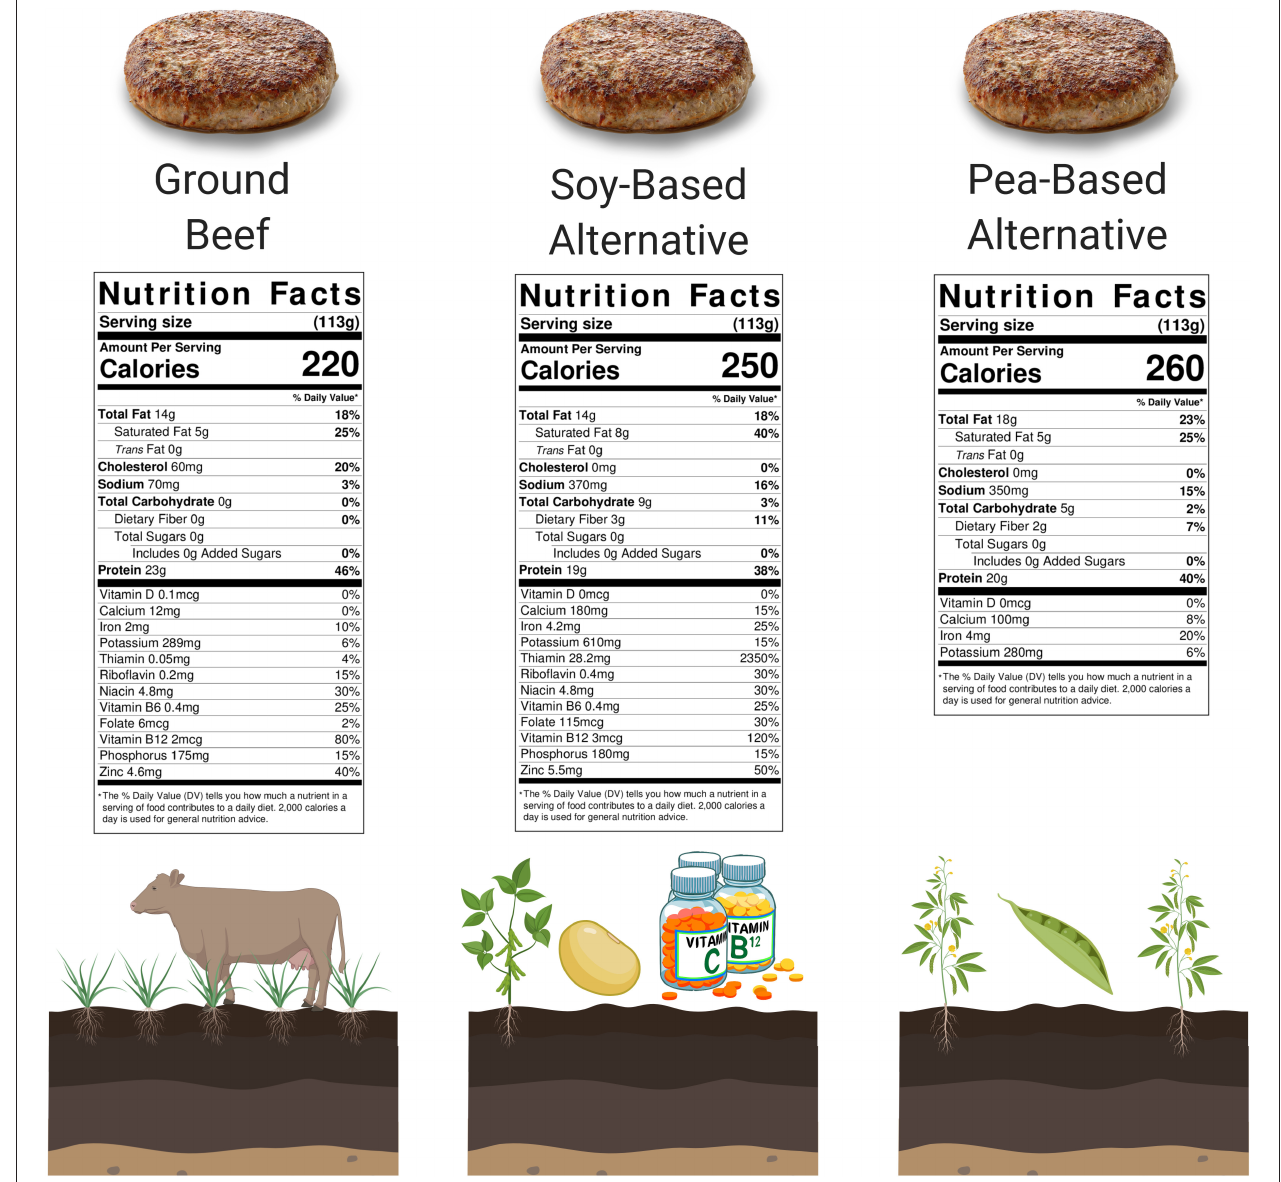
FIGURE 1 | Nutrition Facts panels of 4 oz. (113 grams) of novel plant-based meat alternatives and ground beef. Food sources in their natural state contain thousands of compounds that are capably of impacting human health, the vast majority not appearing on consumer Nutrition Facts panels (Barabási et al., 2019). Despite comparable Nutrition Facts panels, important nutritional differences are expected between beef and the plant-based meats due to differences in their predominant originating source (bovine vs. soy vs. pea-derived). At present, novel plant-based meat alternatives should arguably be treated as meat alternatives in terms of sensory experience, but not per se as true nutritional replacement for meat. It is expected that both beef and plant-based meats will have a have a significant role to play in our future food supply (Godfray, 2019). *A popular soy-based alternative is fortified with iron (from soy leghemoglobin), riboflavin, niacin, vitamin B 6 , vitamin B 12 , and zinc, while a popular pea-based alternative is not fortified. Created with